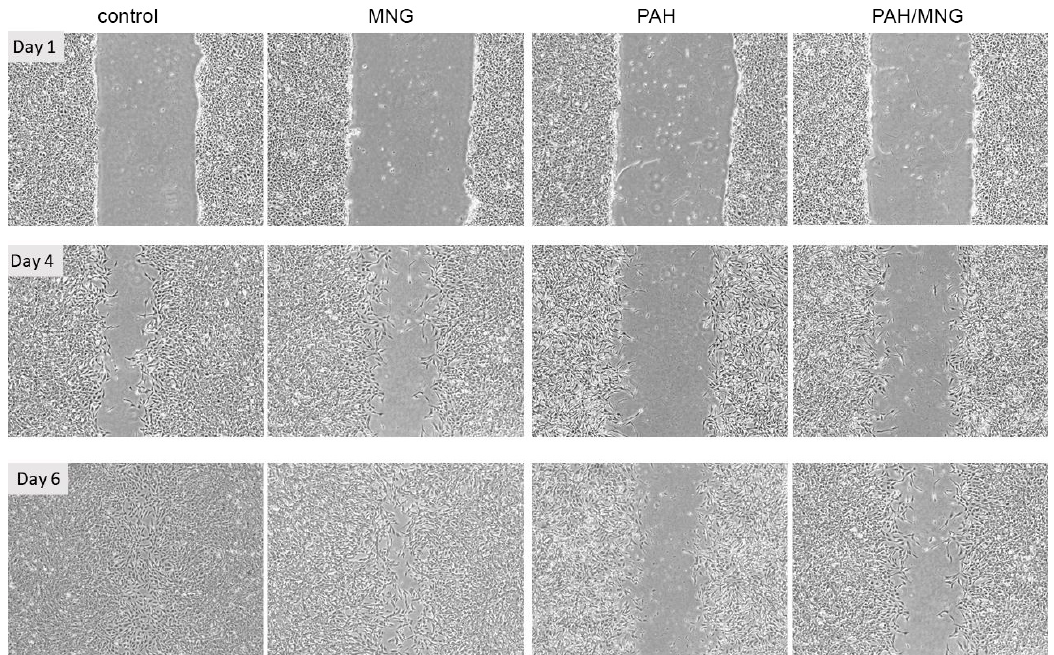
Figure 3. The effects of polycyclic aromatic hydrocarbons (PAH) extract (containing 2 nM of benzo(a)pyrene (BaP)), mangiferin (MNG , 5 µg/mL) or combination thereof on human bronchial epithelial cell wound healing properties. Representative images of wound healing assay in the monolayers of bronchial epithelium under influence of PAH extract, mangiferin and combination of those two compared to the controls. Pictures were taken at day 1, 4 and 6 of the exposure.